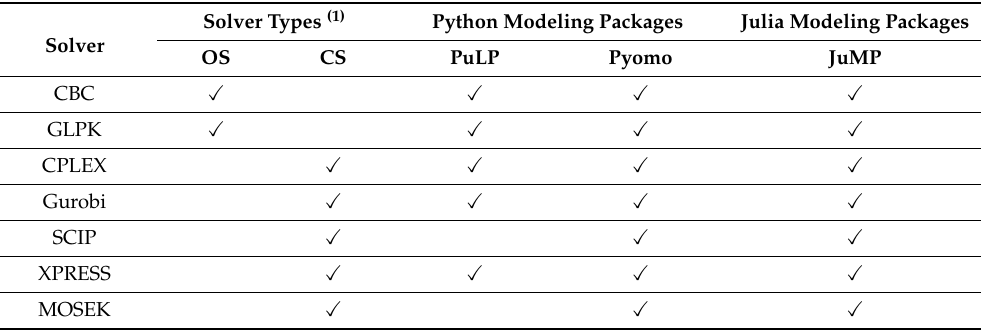
Table 2. Summary of optimization solvers and compatible modeling